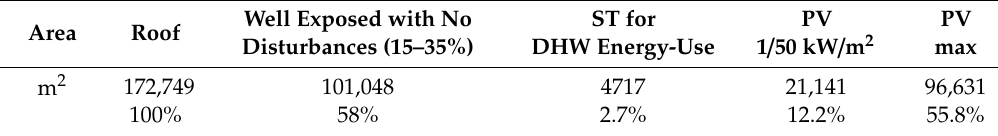
Table 6. Roof area for solar energy